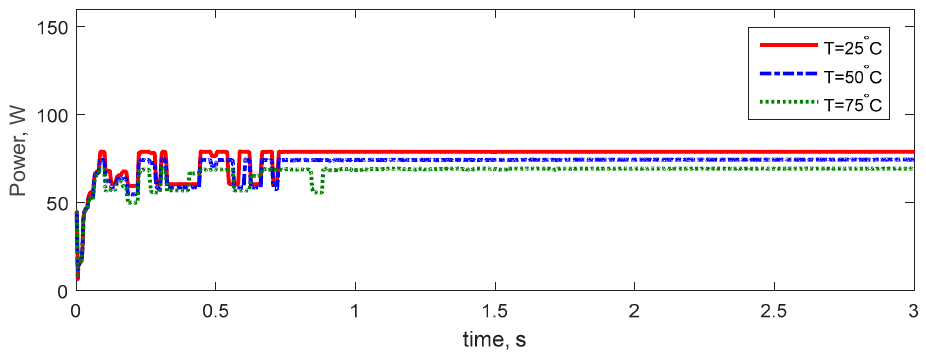
Figure 16. Characteristics of PV considering temperature changes for pattern 4: ( a ) P-V, ( b ) I-V.